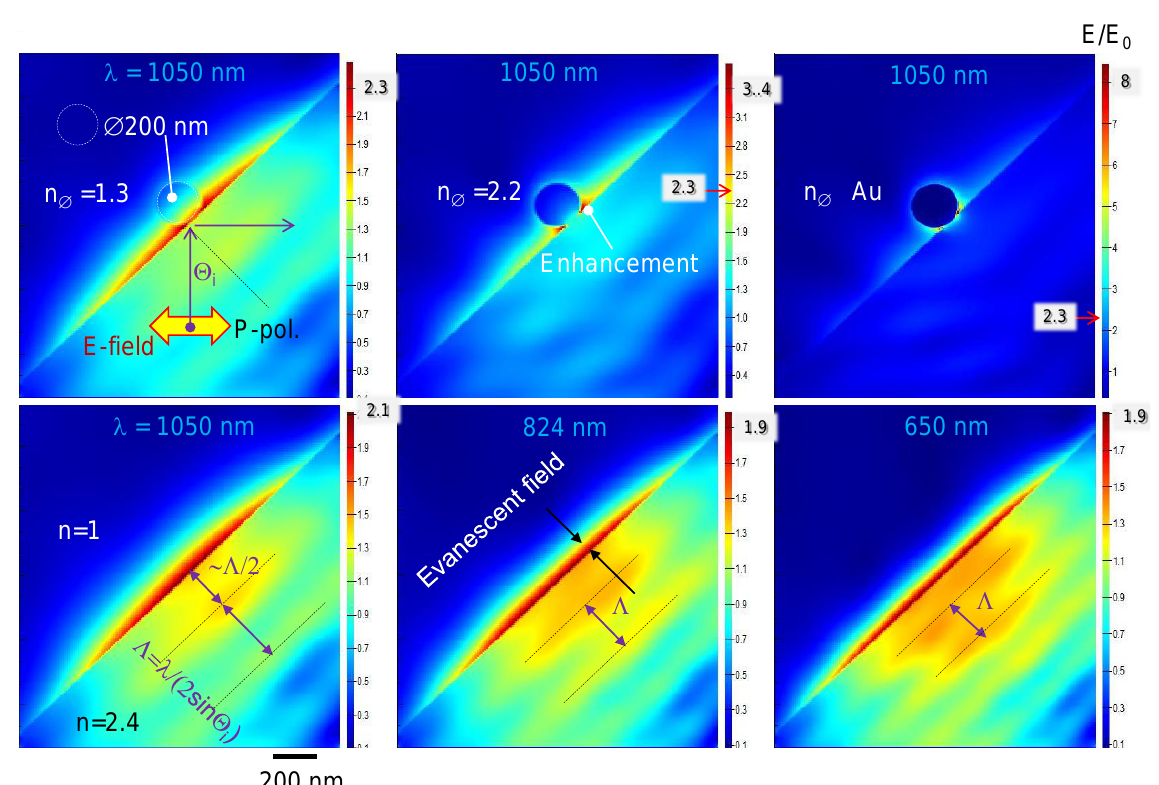
Figure 4. Maxwell’s scaling (change nm to µ m for the same refractive index): numerical finite difference time domain (FDTD; lumerical solutions) calculations for optical wavelengths of λ = 1 µ m – 0.65 µ m to simulate evanescent field at the ATR geometry used (at THz radiation) and at the angle of incidence of θ i = 45 ◦ (ATR interface is 45 ◦ -tilted). Top row shows E-field enhancement when a ∼ λ /20-diameter sphere of refractive index n = 1.3 (water or ice at visible), 2.2 (water or ice at THz) and gold (Au) touches the ATR prism of n = 2.4 (diamond); all intensity maps are calculated for the same wavelength λ = 1050 nm. Bottom row shows the evanescent field at the interface of λ = 1 µ m – 0.65 µ m; the interference maxima are recognisable in the n = 2.4 media (in the wavelength, there is λ / n ). Calculations are carried out for the p-pol. E-field with strength E 0 = 1; hence, E / E 0 scale represents